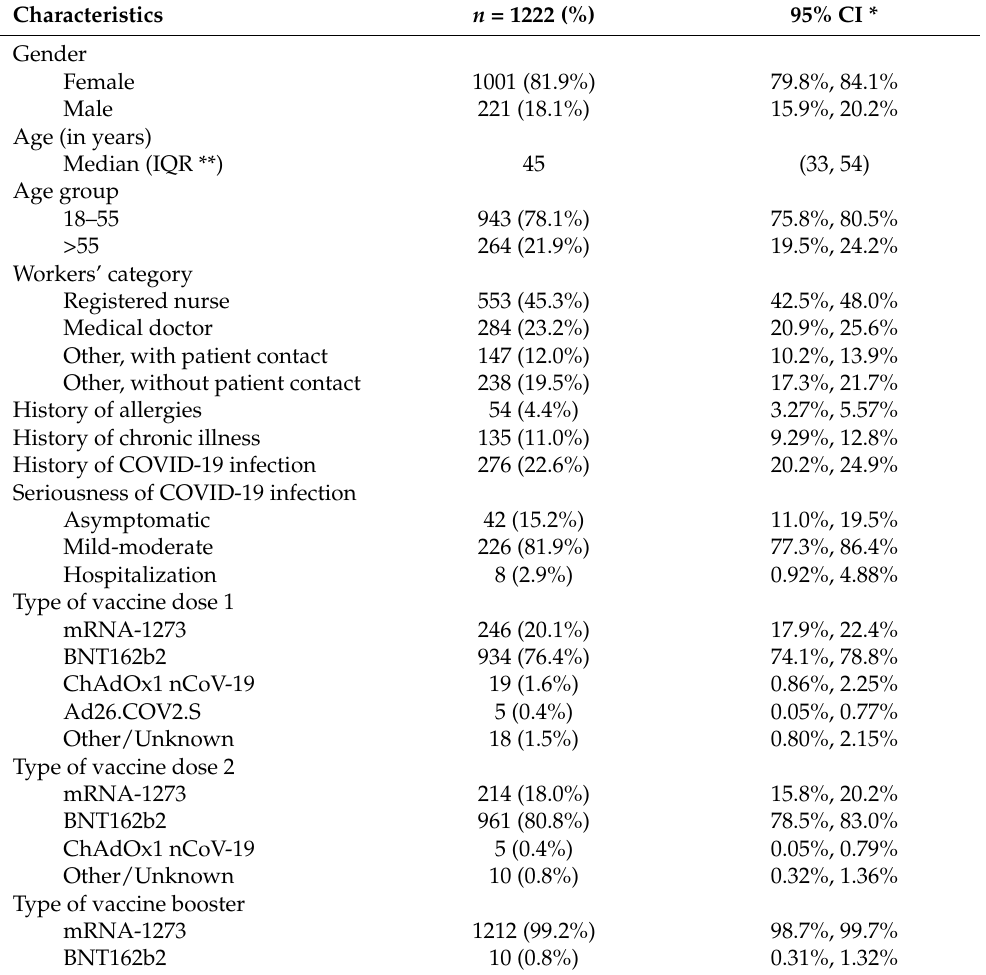
Table 1. The sociodemographic characteristics, medical history, and vaccination history of the